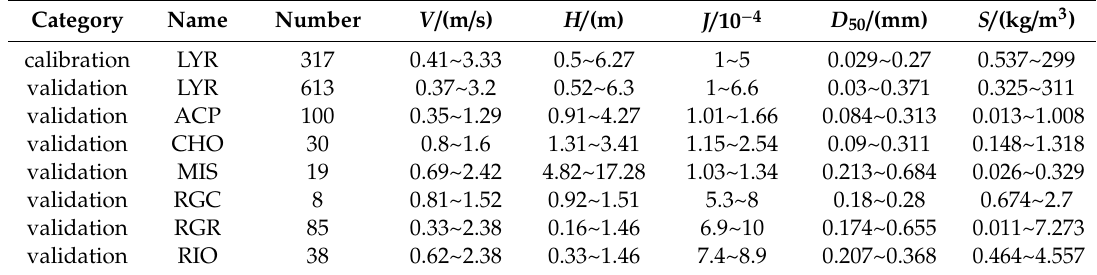
Table 1. Calibration and validation data used in this